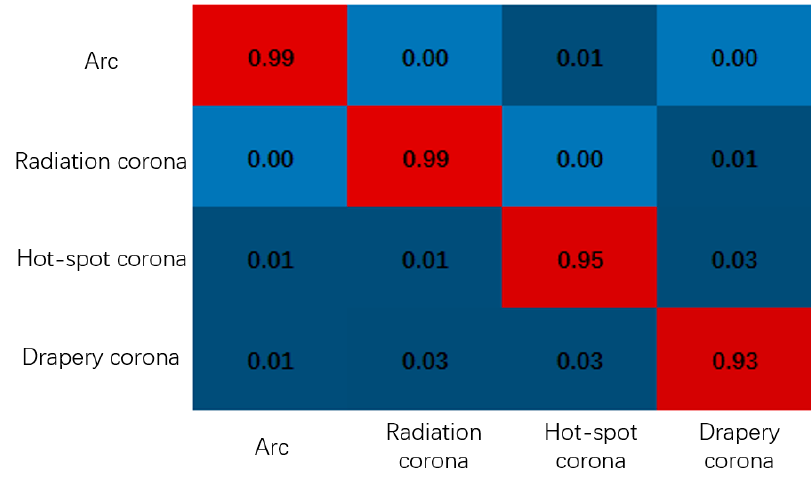
Figure 8. Confusion matrix of AI-MFLDA with the four-class aurora image set.